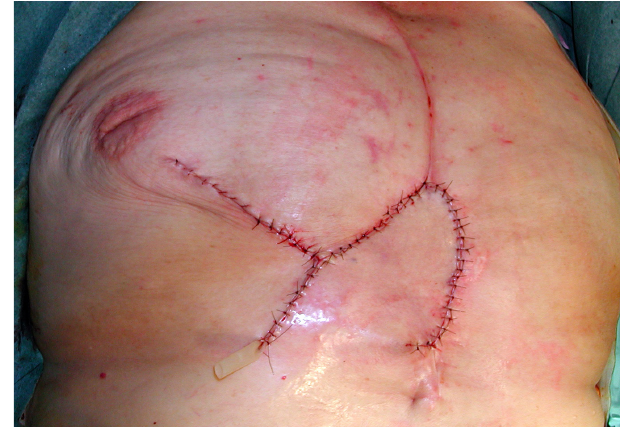
Fig. 3B - Patient with post-CABG on the 10 th postoperative day of dehiscence reconstruction.Classified as Type I, lower partial